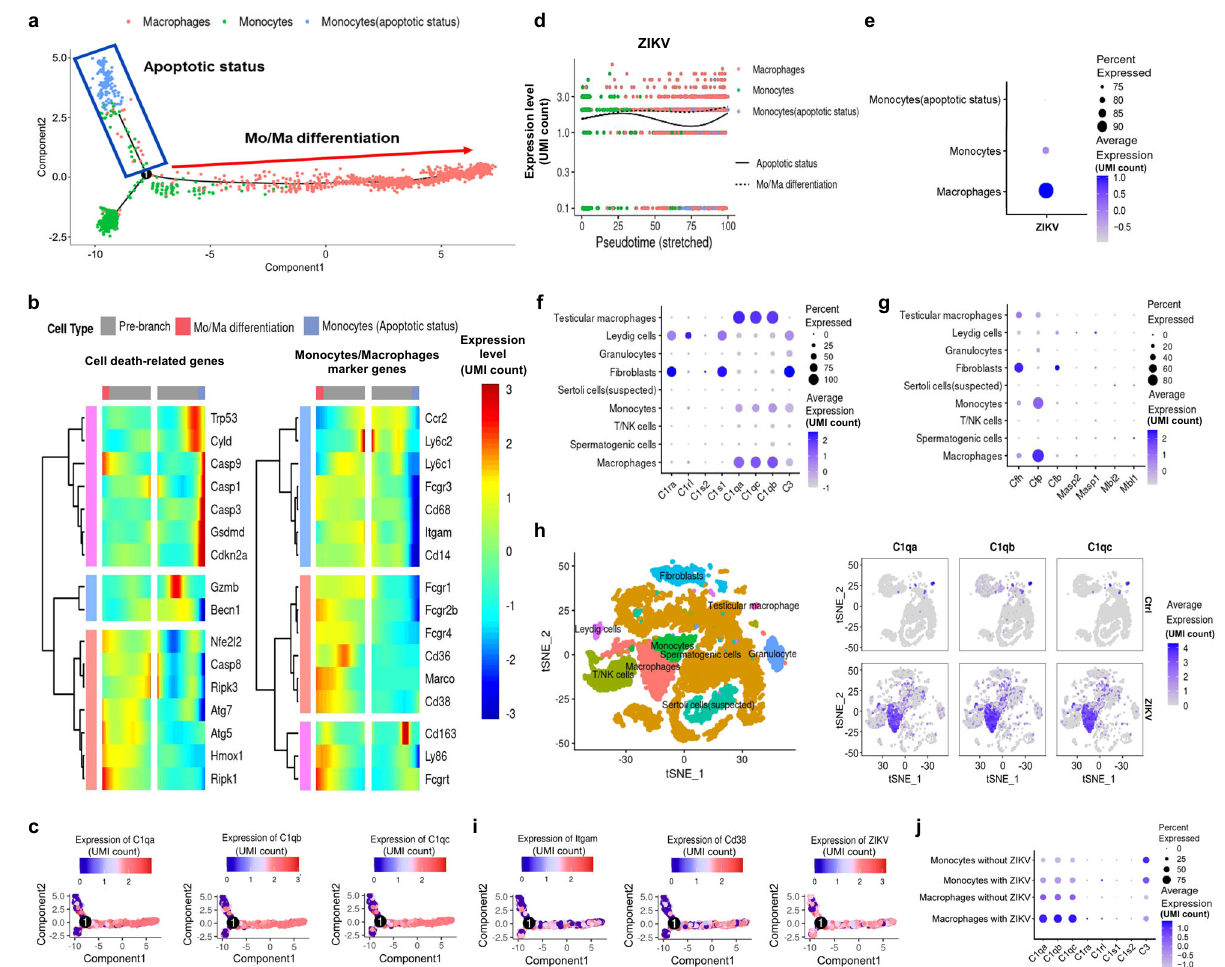
Fig. 3 | Characterization of monocytes and macrophages in control and ZIKV- infected testes by Single-cell sequencing. a Pseudotime analysis of monocytes and macrophages in the testes from ZIKV-infected mice. b The expression of cell death-related genes and monocytes/macrophages marker genes were shown in heatmap. c Thesignaturesandexpressiondynamicsof Itgam and Cd38 andZIKVin monocytes and macrophages were shown in pseudotime progression. d , e The expressionofZIKVRNAinmonocytesandmacrophageswasshowninlinechart( d )